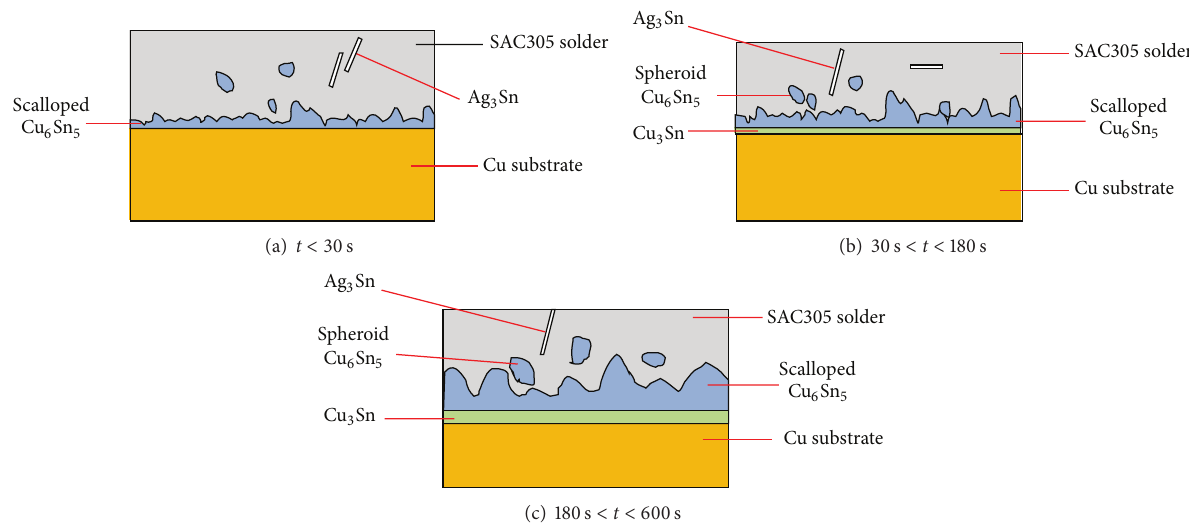
Figure 11: Growth mechanism of Cu-Sn IMCs at various reflow times: (a) formation of scallop Cu 6 Sn 5 at the SAC305/Cu interfacial region, (b) appearance of Cu 3 Sn between the Cu 6 Sn 5 /Cu interface, and (c) increase in both Cu-Sn IMCs thicknesses with increasing reflow times.